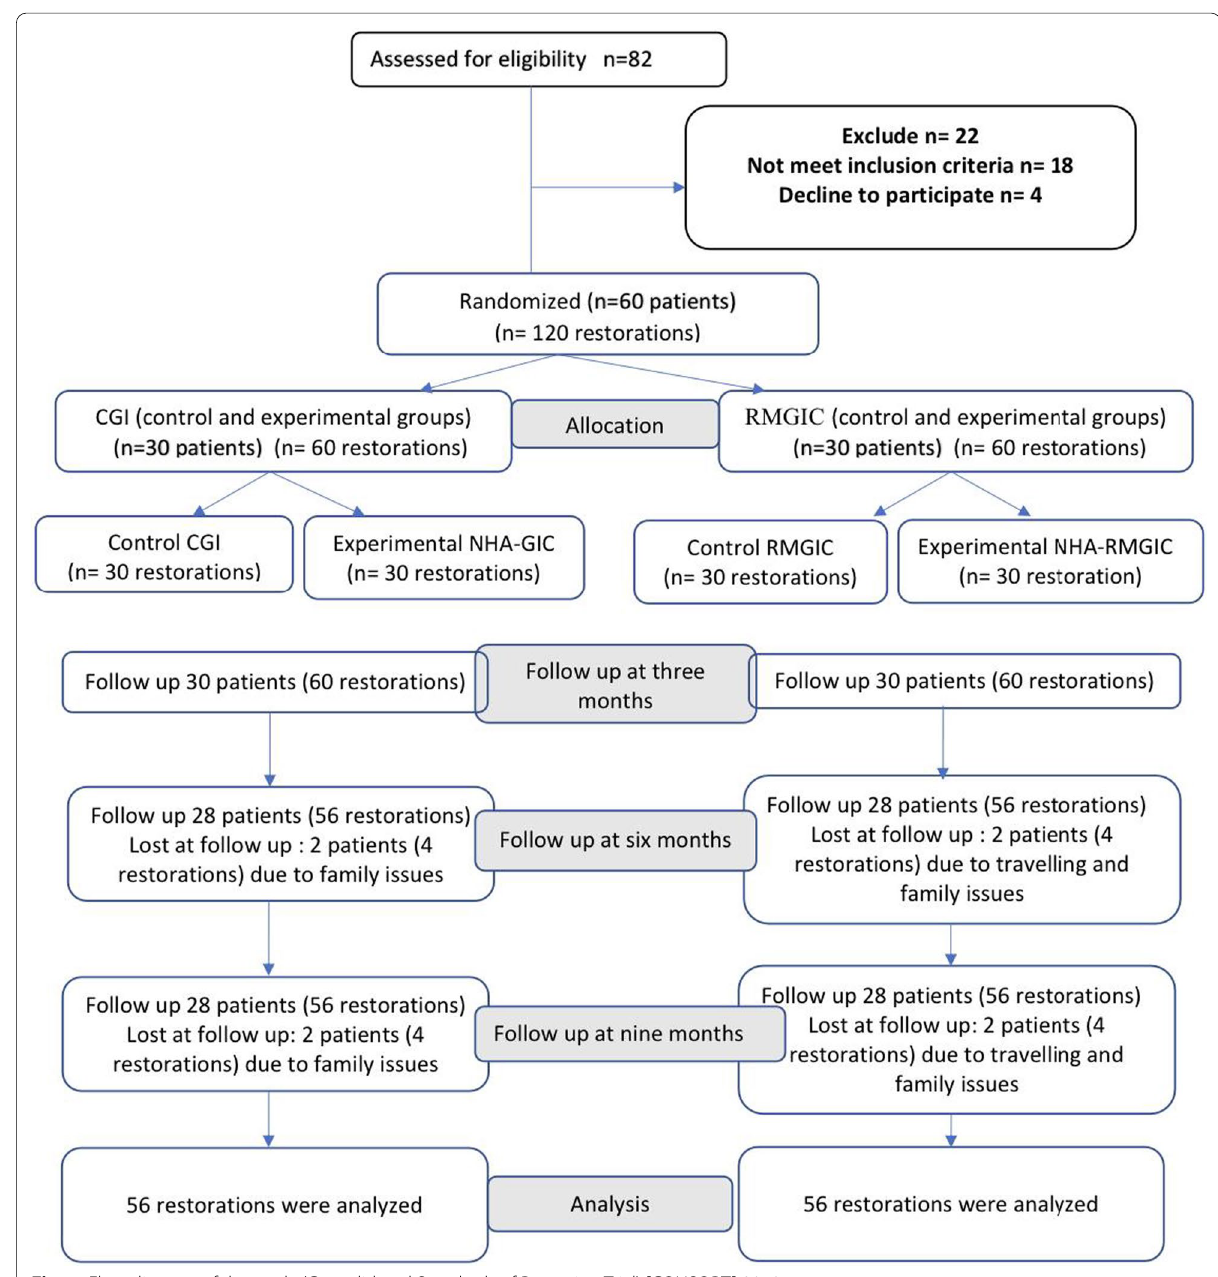
Fig. 1 Flow diagram of the study (Consolidated Standards of Reporting Trial) [CONSORT]